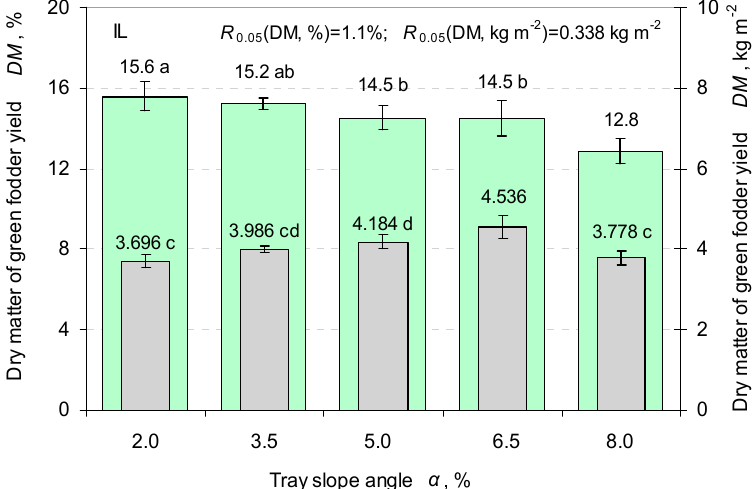
Figure 4. Influence of the slope angle of the growing tray ( α ) on fodder dry matter (DM) after seven days of cultivation using indoor lighting. Each vertical bar is 95% confidence interval. Any two samples with a common letter are not significantly different ( p < 0.05), as assessed using the least significant difference.